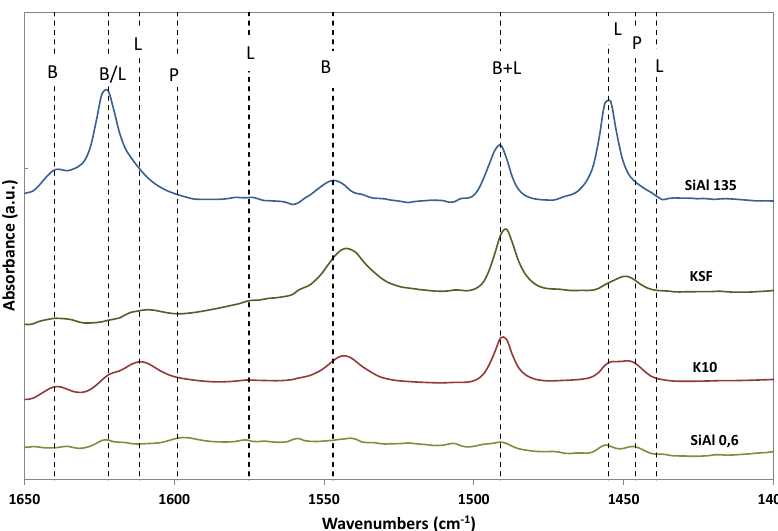
Figure 1. FTIR spectra of pyridine adsorbed on the silica–alumina catalysts: P = physisorbed, B = Brønsted sites, L = Lewis acid sites.